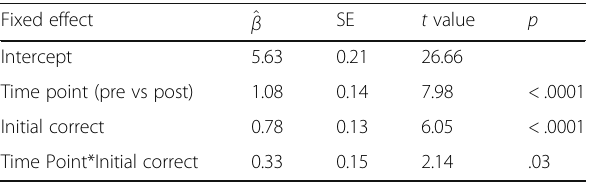
Table 5 Logit mixed-level regression analysis Fixed effect